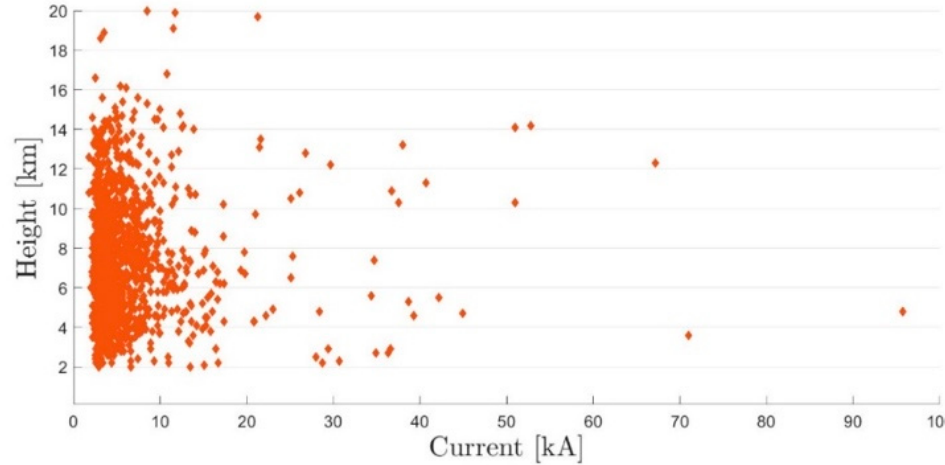
Figure 7. LINET lightning amplitude distribution in the Mt. Cimone area along the height for IC strokes. Area considered: 5 km radius around the Observatory. Data range: 2012–2020.